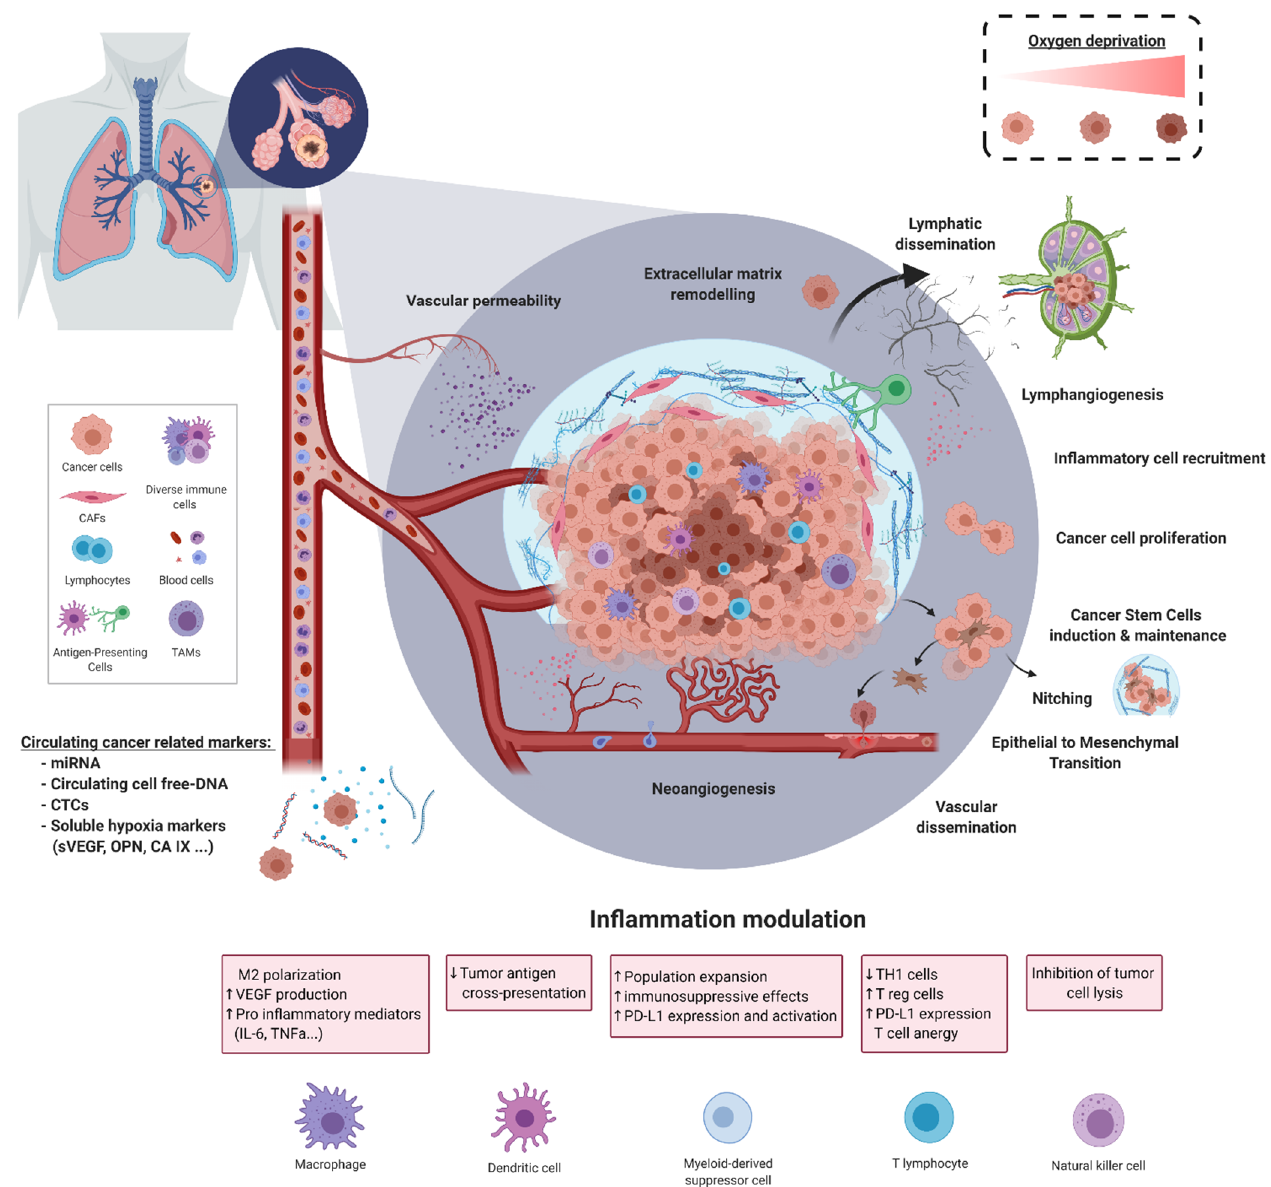
Figure 1. Schematic representation of lung cancer properties induced by hypoxic conditions. Hypoxia drives many mechanisms broadly involved in aggressiveness, invasion, and leading to the acquisition of metastatic properties. Additionally, oxygen deprivation supports the modulation of inflammation associated with an immune escape.